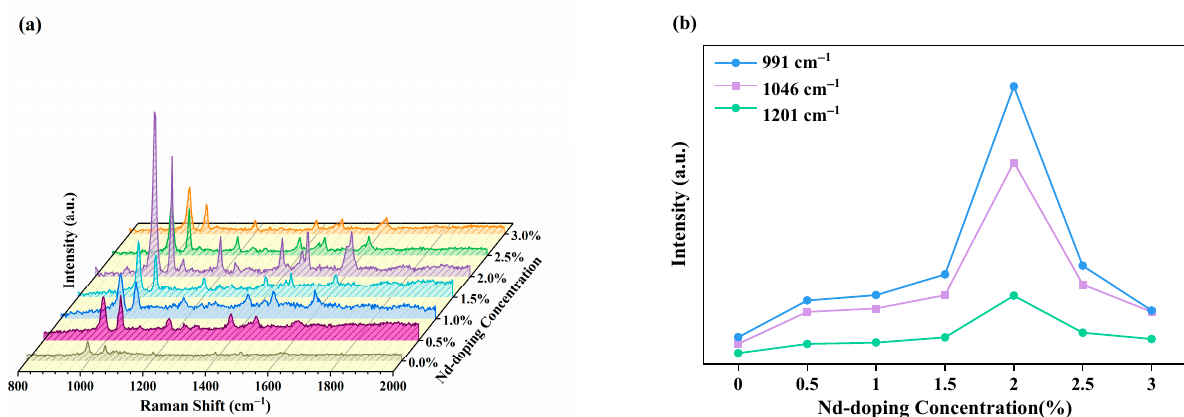
Figure 5. ( a ) SERS spectra of 4-Mpy (10 − 2 M) with different Nd doping concentrations; ( b ) Raman intensity for 4-Mpy with different Nd doping concentrations at 991, 1201, and 1046 cm − 1 peaks.